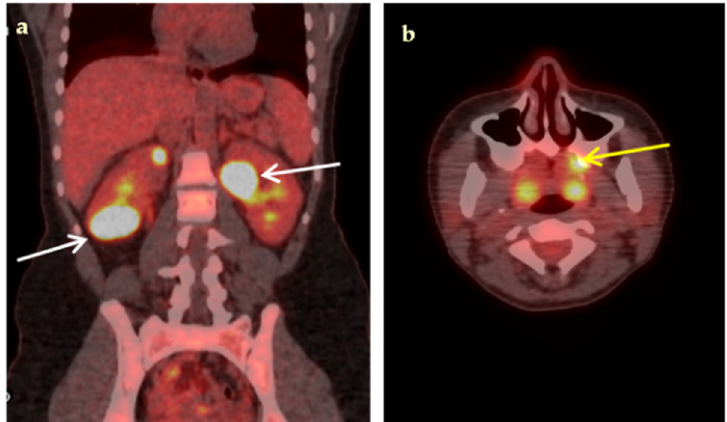
Figure 2. An 18-year-old woman presented with a 3-week fever, elevated inflammatory blood markers (ESR 77 mm/h, CRP 9.3 mg/dL) and an abdominal CT scan suggestive of possible renal abscesses. Coronal fused 18 F-FDG-PET/CT image ( a ), demonstrated multiple hypodense, highly hypermetabolic lesions in both kidneys, the largest (white arrows) in the lower pole of the right kidney (SUVmax 35.3) and in the upper pole of the left kidney (SUVmax 34.4), compatible with renal abscesses, confirmed by biopsy. Transaxial fused 18 F-FDG-PET/CT image ( b ) demonstrated high 18 F-FDG paradental uptake in the left maxilla (yellow arrow) raising concern for hematogenous spread of dental infection. Complementary focused interrogation revealed a history of a painful, undertreated dental condition of the left maxilla preceding fever.